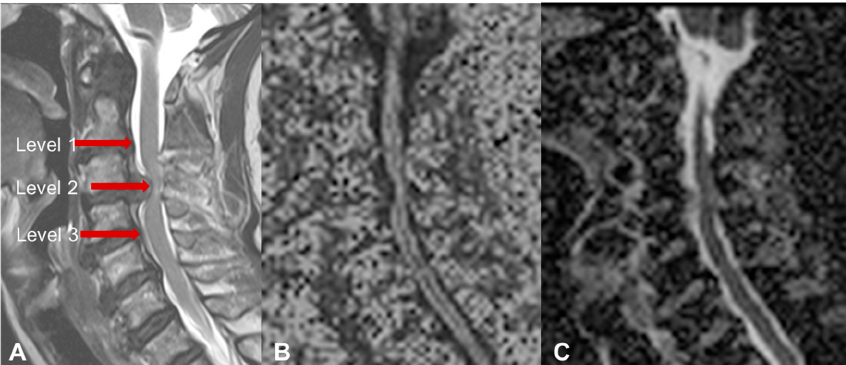
Figure 1. A : Measurement levels for fractional anisotropy (FA) and the apparent diffusion coefficient (ADC): The surgical level, or the narrowest point of the cervical stenosis in patients with multilevel compression (level 2), and the intervertebral levels above and below it (level 1 and 3). B, C : Diffusion tensor imaging (DTI) sequences for FA and ADC measurement, respectively.